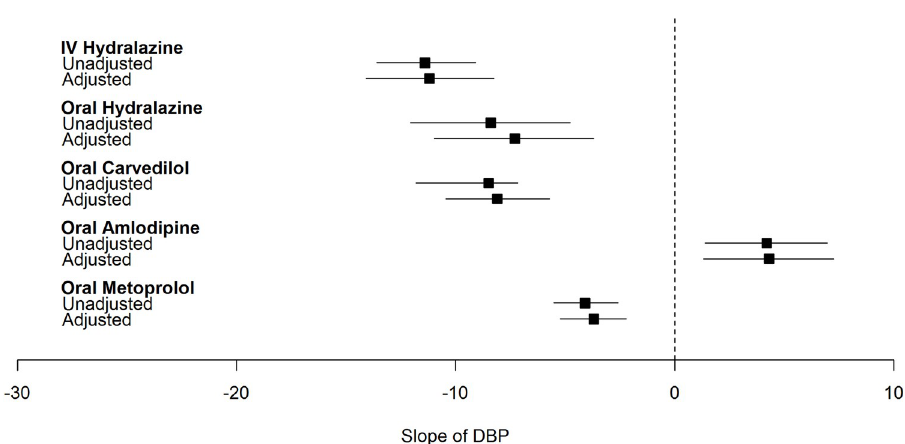
Fig 4. Plot of effect estimate ( β [95%CI]) of common antihypertensives on slope of diastolic blood pressure within 6 hours of severe inpatient hypertension development. Adjusted for age, sex, race, ethnicity, ward, comorbidities (congestive heart failure, cardiac arrythmia, valvular disease, pulmonary circulation disorder, peripheral vascular disease, hypertension, paralysis, other neurological disorders, chronic pulmonary disease, diabetes, hypothyroidism, renal failure, liver disease, peptic ulcer disease excluding bleeding, AIDS/HIV, lymphoma, cancer, rheumatoid arthritis/collagen disorder, coagulopathy, obesity, weight loss, fluid and electrolyte disorders, blood loss anemia, deficiency anemia, alcohol abuse, drug abuse, psychosis, depression), baseline laboratory values (sodium, potassium, chloride, bicarbonate, BUN, eGFR, WBCC, platelet count, hemoglobin, hematocrit), NSAID use 0–6 hours before time of severe inpatient HTN, crystalloid use 0–6 hours before time of severe inpatient HTN, steroid use 0–6 hours before time of severe inpatient HTN, narcotic use 0–6 hours before time of severe inpatient HTN, sedative use 0–6 hours before time of severe inpatient HTN, maximum MAP before time of severe inpatient HTN development, minimum MAP before time of severe inpatient HTN development, coefficient of variation of MAP before time of severe inpatient HTN development. hospital.